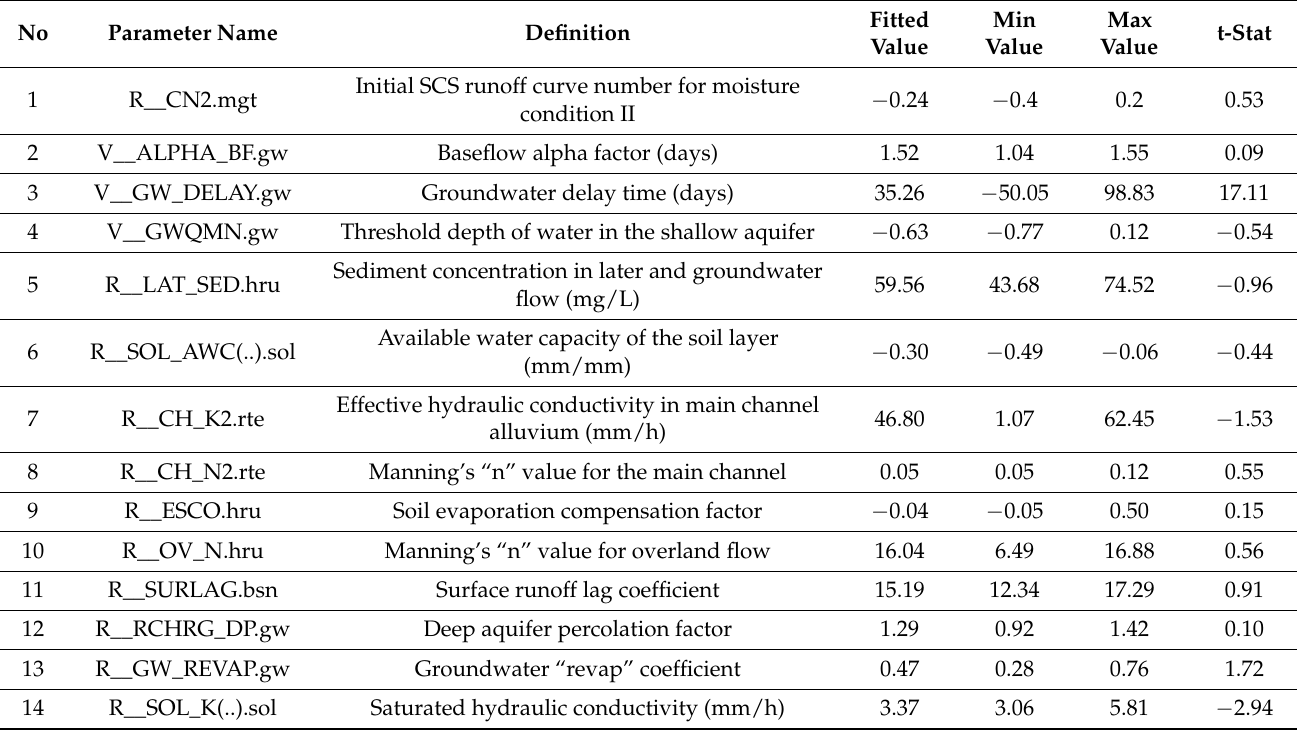
Table 3. Flow sensitive parameters and their fitted value in SUFI2.